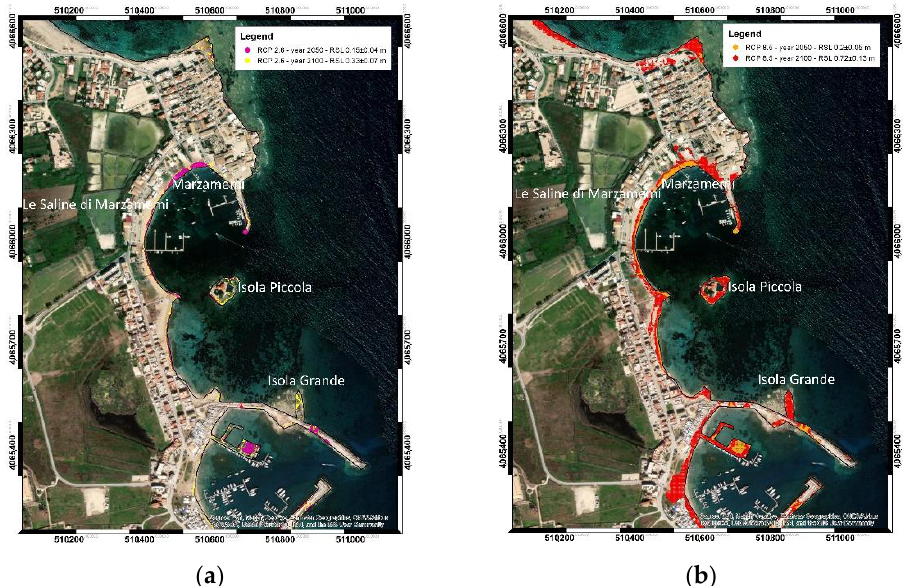
Figure 13. The coast of Marzamemi. In colors are reported the expected extension of flooding in 2050 and 2100 for ( a ) RCP 2.6 and ( b ) RCP 8.5 climatic scenarios. The expected maximum loss of land is 0.043 km 2 (high-resolution maps are inserted in Supplementary Materials Maps S8–S9). VLM are about null except for the area of the modern harbor (at the bottom in the figure), which is affected by a subsidence at 1.02 ± 2.5 mm/yr.